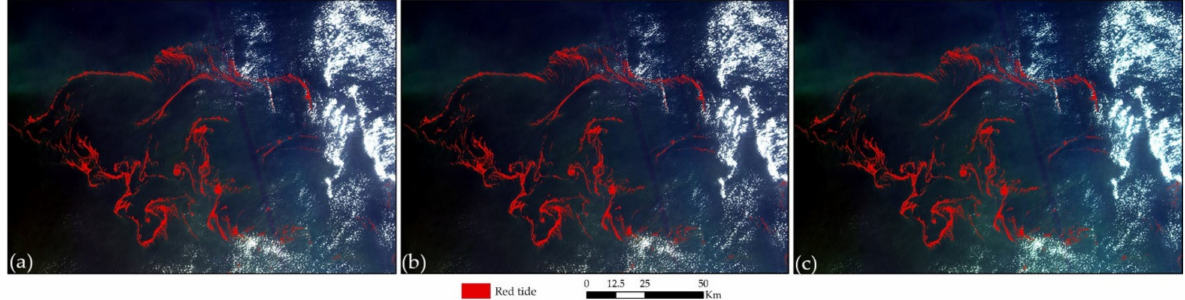
Figure 9. Red tide detection results based on different datasets. ( a ) Validation map; ( b ) Red tide detection result for the multi − feature dataset; ( c ) Red tide detection result for the four − bands dataset. The red regions represent red